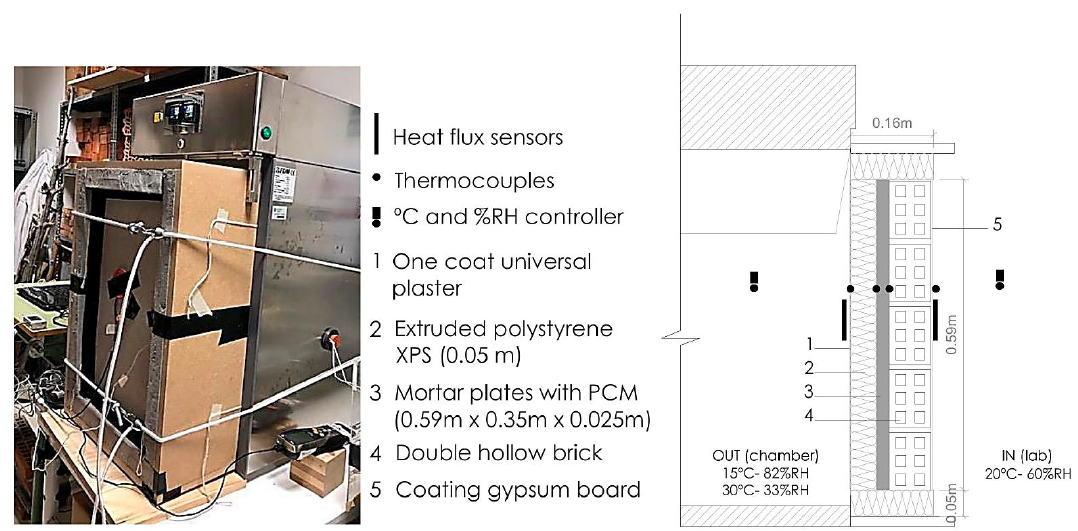
Figure 2. Climatic chamber set-up for monitoring the brick walls in di ff erent temperature Figure 2 . Climatic chamber set - up for monitoring the brick walls in di_erent temperature conditions